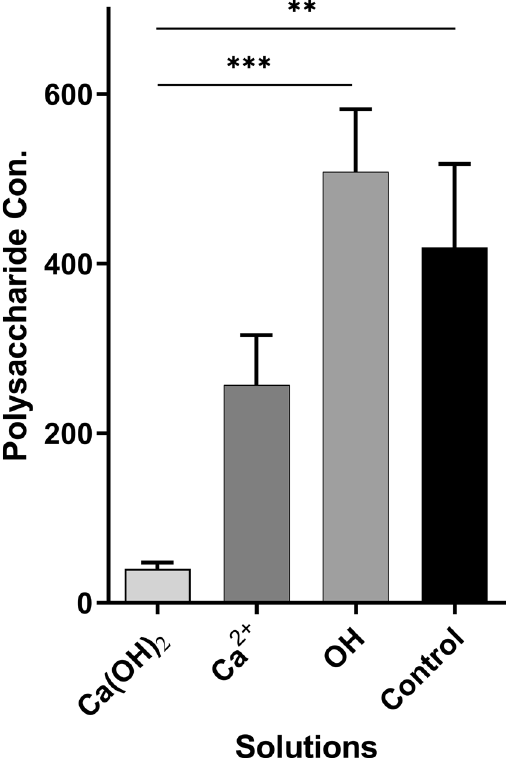
Figure 6. Measured polysaccharide concentrations by groups. Significance token: *, 0.05; **, 0.01; ***, 0.001; Non-significant results are not shown.